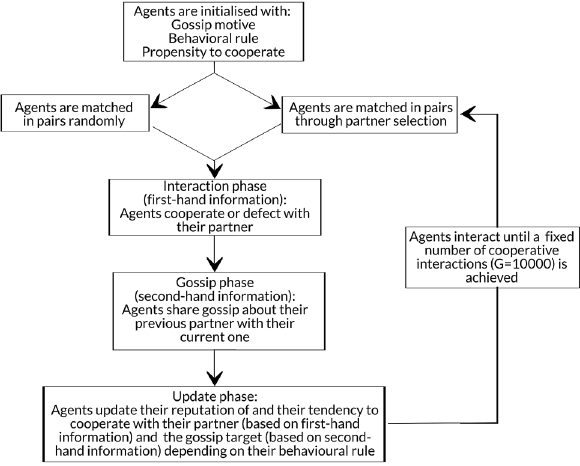
Figure 1. Flowchart of the model dynamics. During initialization, agents are assigned a gossip motive and a behavioral rule that remains constant throughout the entire simulation (see SI, section S1.2 and S1.5). Agents are also initialized with a baseline propensity to cooperate drawn from a normal distribution with variance 5 and mean 50 (see “Methods” section). Agents are either matched with random partners throughout the entire simulation or they select their partner based on their reputation (see “Methods” section and SI, section S1.3). When partner selection is modelled, agents are matched randomly for the first 50 rounds to allow reputational information to be